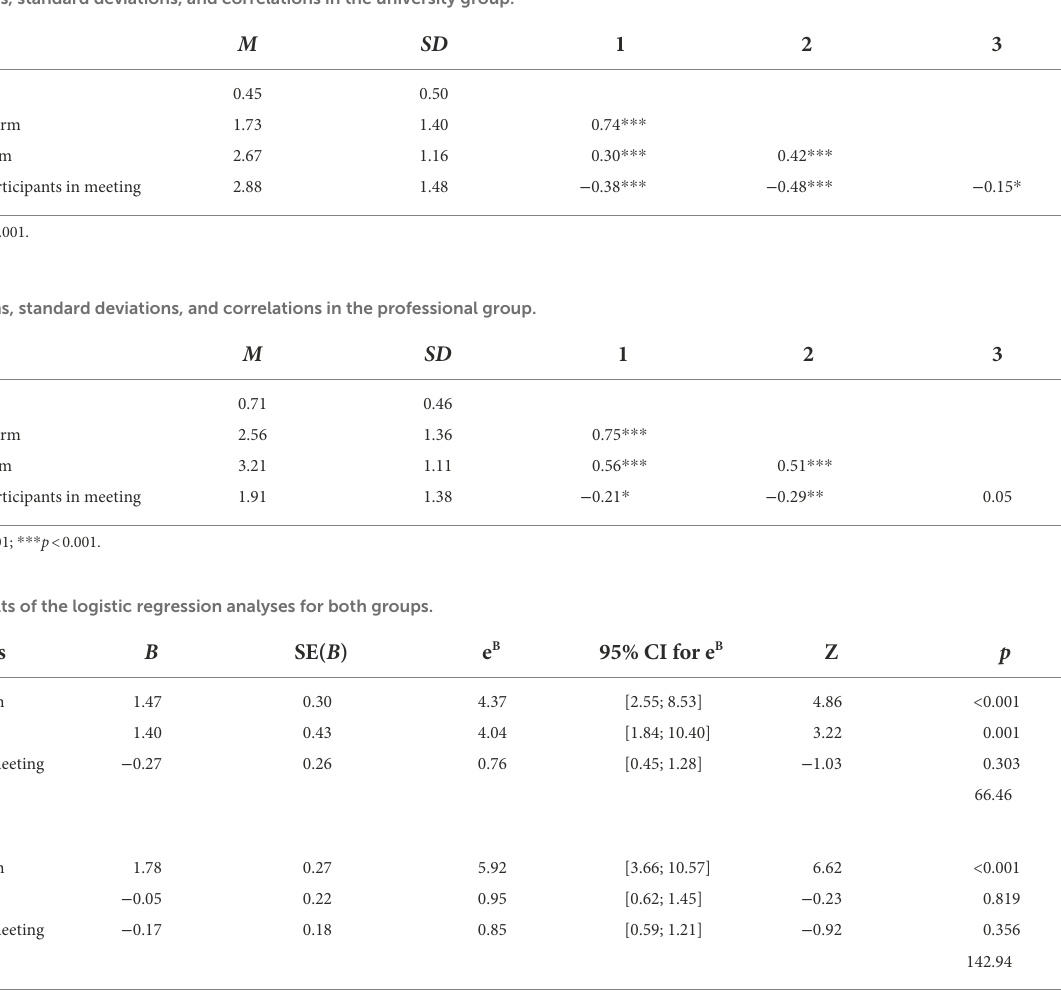
TABLE 1 Means, standard deviations, and correlations in the university group.